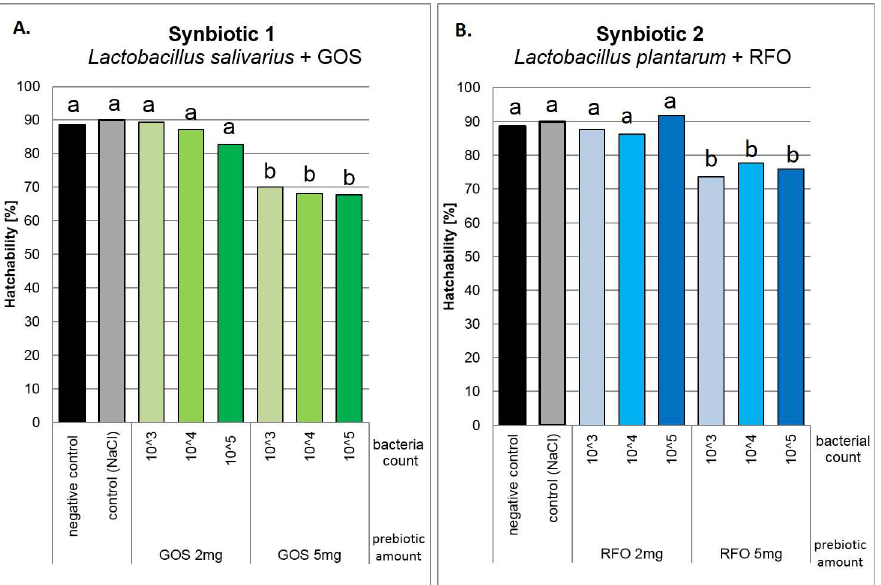
Fig 2. Chick hatchability in response to different doses of synbiotics delivered in ovo for (A) L . salivarius + GOS (S1) and (B) L . plantarum + RFO (S2). Six doses of two synbiotics were deliveredat 12 th day of incubation.Combinationof three doses of probiotics(10 3 , 10 4 , 10 5 cfu egg -1 ) with two doses of prebiotics (2 mg egg -1 or 5 mg egg -1 ) were tested. The highest dose that did not decreasehatchability (10 5 cfu egg -1 of prebioticand 2 mg egg of probiotic) was selectedfor the field trial. One-way analysisof variance (ANOVA) was performed.Duncan’spost hoc test was appliedto comparethe mean values betweenpairs in the experimental groups(a, b: P <